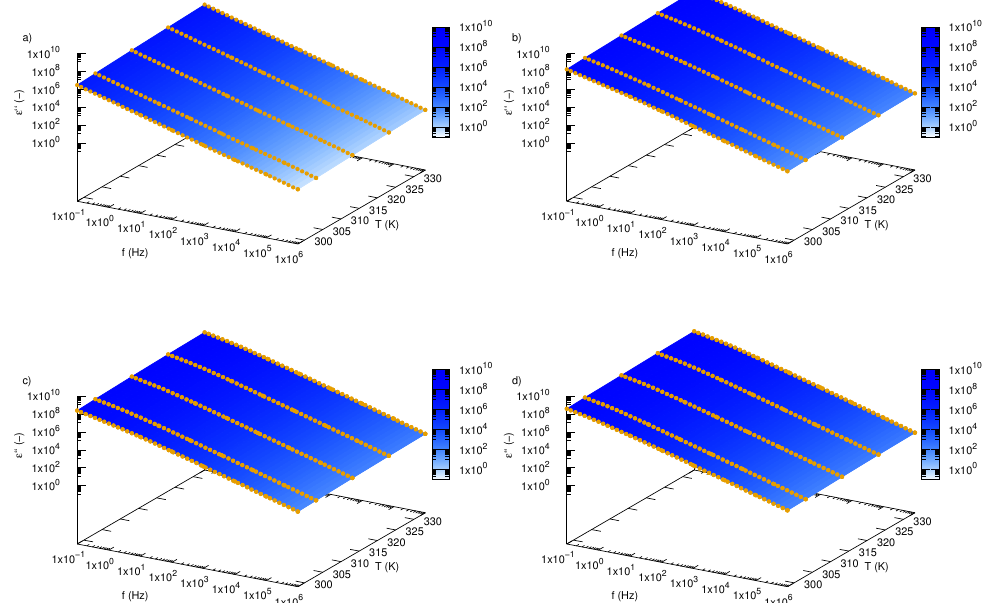
Figure 4. Imaginary part of permittivity, ε ”, of silicon oxide lignin ethylene glycol nanofluids as function of frequency and temperature for ( a ) pure ethylene glycol, ( b ) 0.01 mass fraction, ( c ) 0.02 mass fraction, ( d ) 0.03 mass fraction.